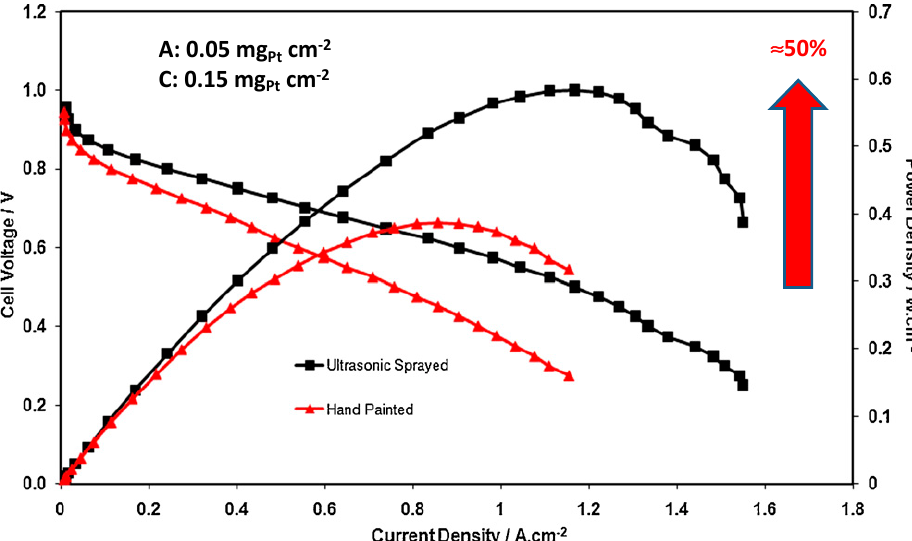
Figure 15. Polarization and power density curves comparing ultrasonic-sprayed and hand-painted SGL 10BC GDLs. Anode (A) = 50%; cathode (C) = 50%. The loadings for the MEAs were; ultrasonic sprayed: A = 0.05 mg cm − 2 , C = 0.15 mg cm − 2 and hand-painted: A = 0.09 mg cm − 2 , C = 0.18 mg cm − 2